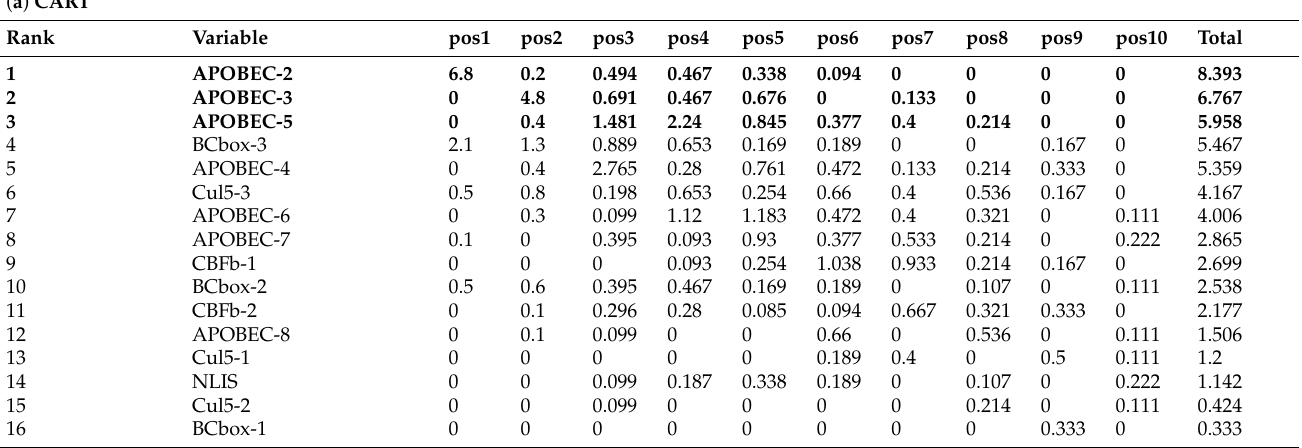
Table A2. Relevance scores ( r ) in descending order per algorithm and variable considering the clinical endpoint CD4Hist using the MAREV-1 approach. The three variables with higher values are highlighted in